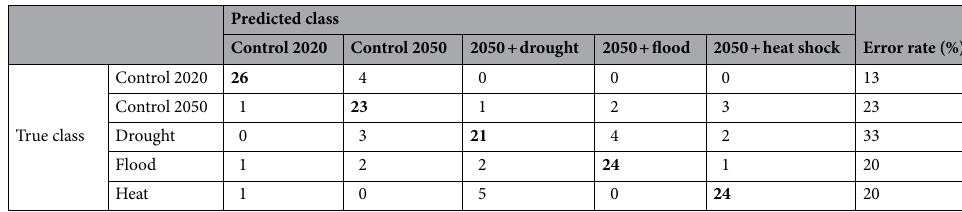
Table 5. Results from random forest classification of VOC samples by growth condition at 24 h post incubation. Rows represent the number of samples from each true class that were allocated to each of the predicted classes (columns). The error rate is the percentage of samples that were misclassified from each group. The predicted class for each given sample was determined by a simple majority of votes from the trees in which that sample was out-of-bag (OOB). Correct classifications are shown in bold.